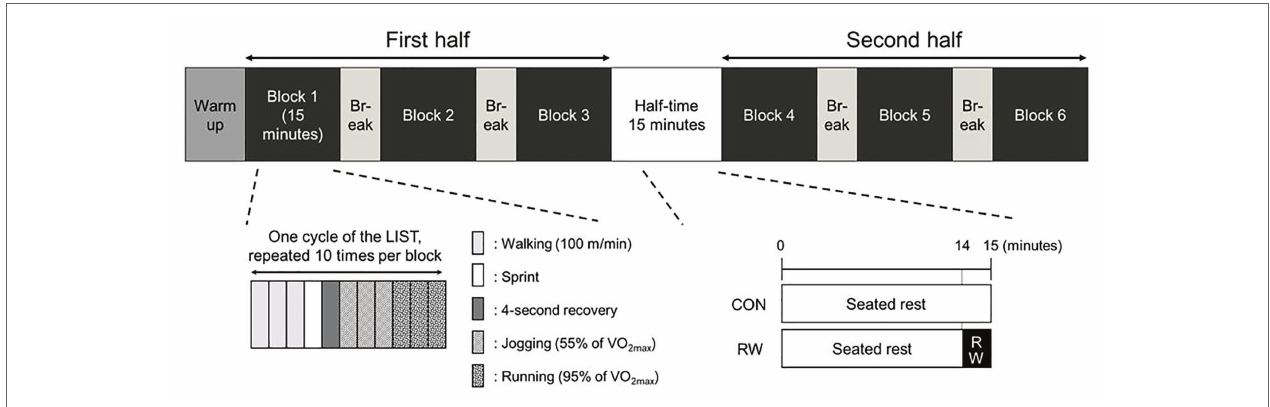
FIGURE 1 | Schematic representation of the study protocol. CON: 15-min seated rest trial, RW: 1-min re-warm up at high-intensity trial, LIST: Loughborough Intermittent Shuttle